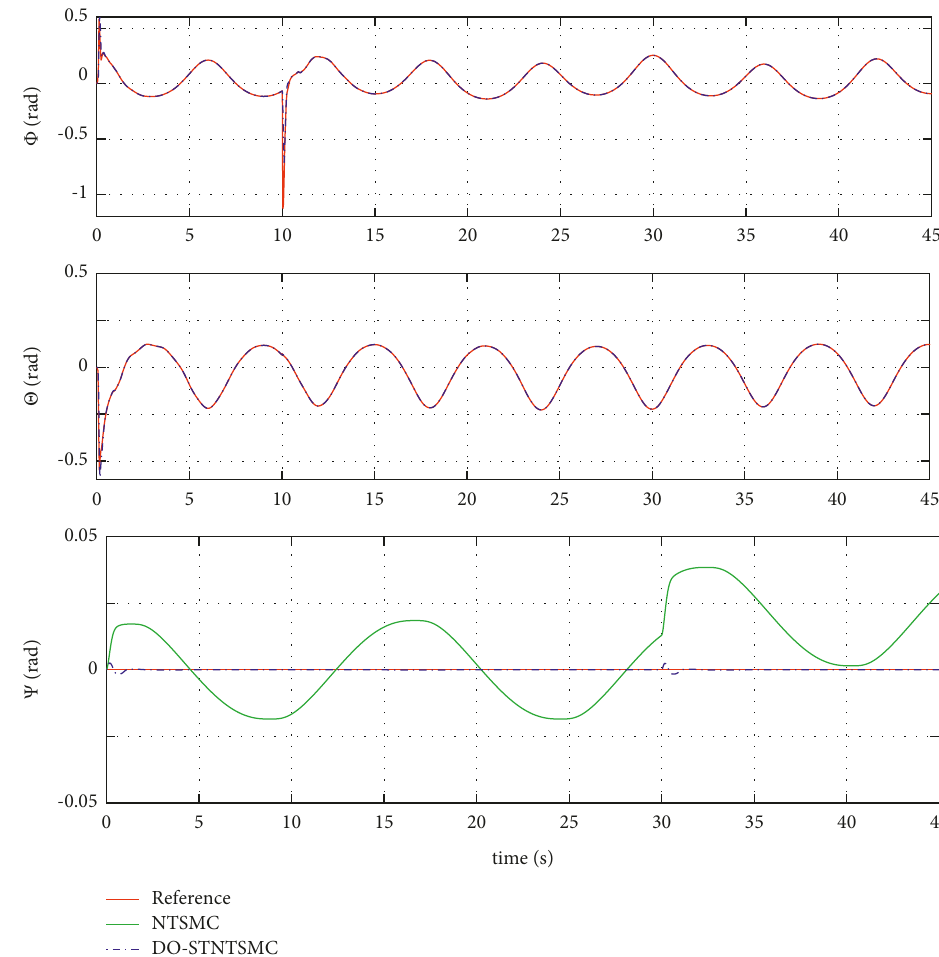
Figure 14: Time response evaluation of the quadrotor’s attitude in the second scenario.